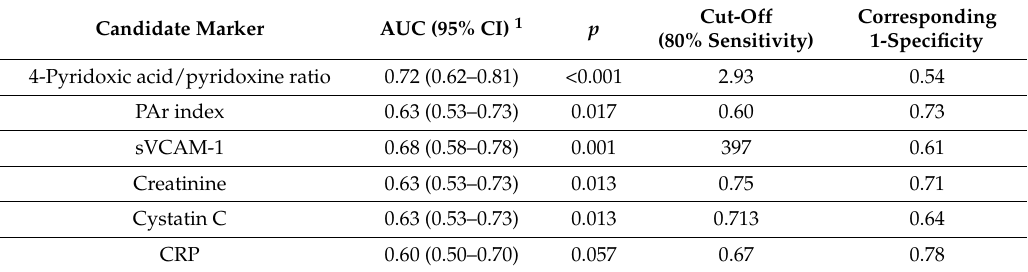
Cut-Off Corresponding (80% Sensitivity) 1-Specificity